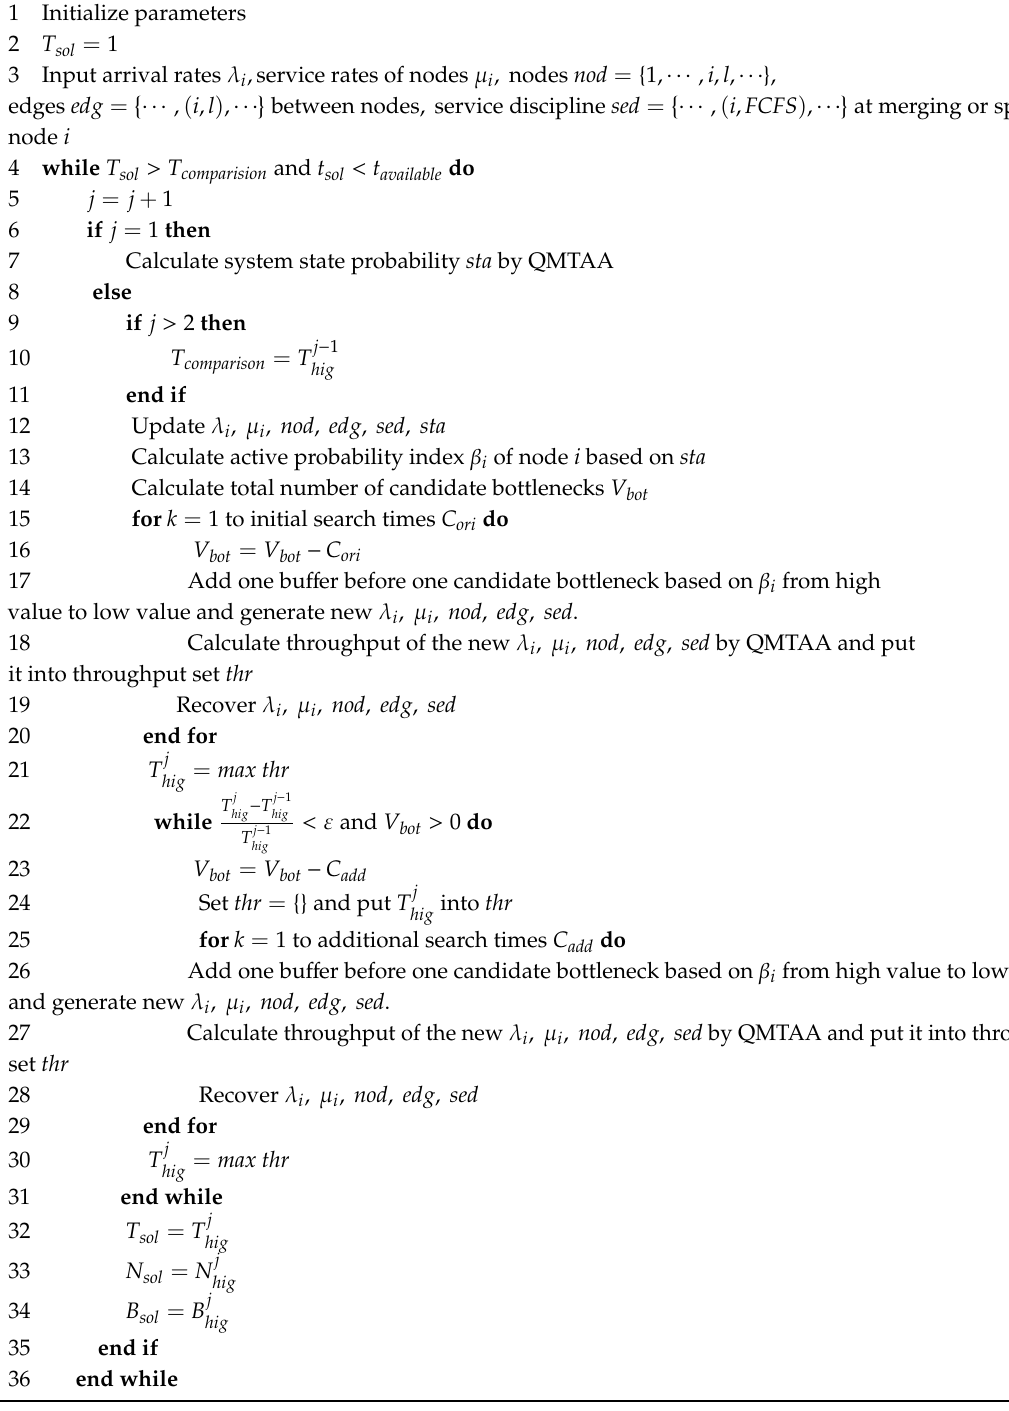
Algorithm 1: bottleneck-based variable neighborhood search algorithm 1 Initialize